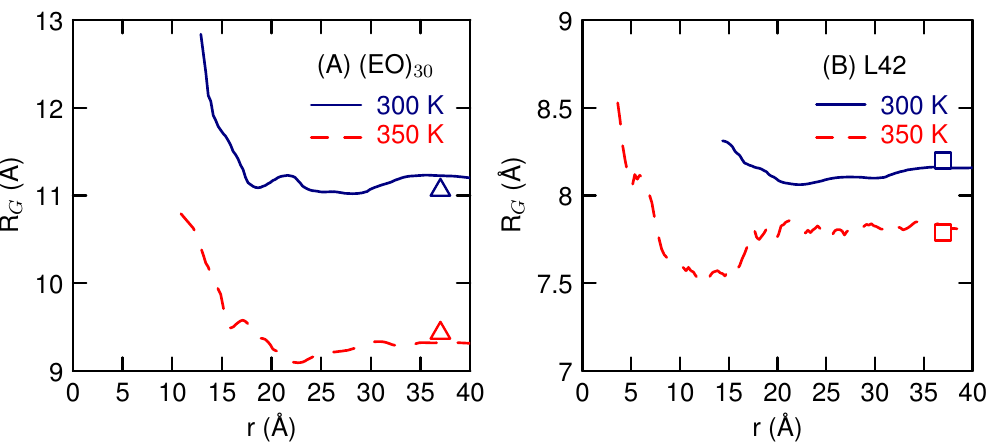
Figure 11. The single-polymer radius of gyration as a function of the distance between the centers-of-mass of the two polymers for ( A ) EO 30 and ( B ) L42. The symbols give the corresponding R G for the isolated polymer. The water structure around the polymers, as given by the radial distribution function between the polymer and water oxygens (Figure 12) is similar to the results of the single polymer (Figure 7) showing a weak temperature dependence. For (EO) 30 , the hydrogen-bonding peak, at 2.8 Å, indicates that there is one nearest-neighbor water molecule near the oxygen atom, at 300 K. The peak heights decrease slightly with temperature. The water structure around L42 is significantly reduced relative to (EO) 30 , with a water coordination number around 0.5. Structures of the contact pair, at 350 K, were used to analyze the solvent structure (the CP curve on Figure 12B). The contact pair is taken to be any pair that has a center-of-mass distance less than 17 Å. This shows that the first peak is about the same, whether or not the polymers are in contact, so contact does not displace nearest neighbor water molecules.